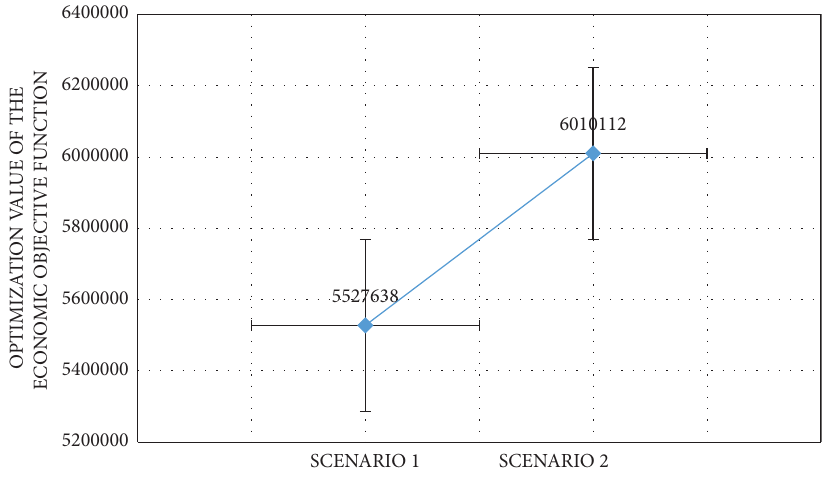
Figure 10: Sensitivity analysis of economic aspect (normal COVID) models.